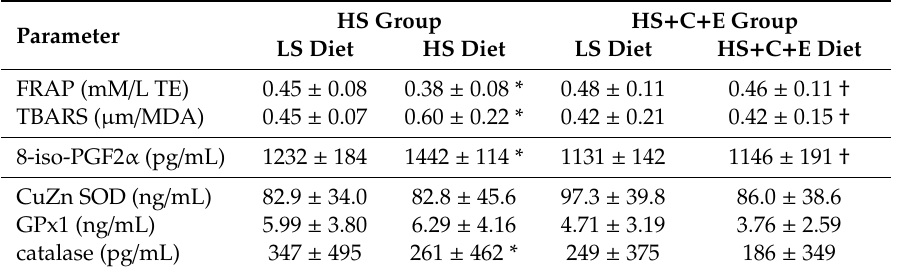
Table 3. The effect of the 7-day high-salt diet without (HS group) or with vitamin C and E (HS+C+E group) intake on markers of oxidative stress and antioxidative defense. Table 3. The e ff ect of the 7-day high-salt diet without (HS group) or with vitamin C and E (HS + C + E group) intake on markers of oxidative stress and antioxidative defense.